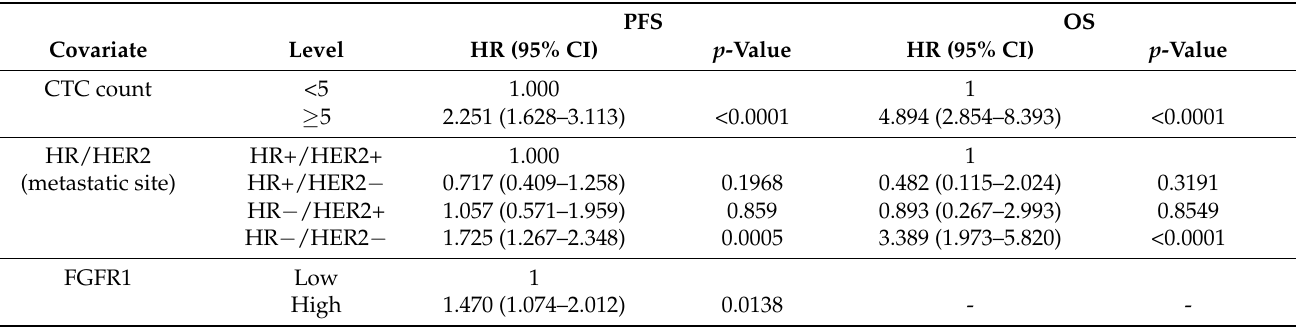
Table 2. Time-dependent Multivariate